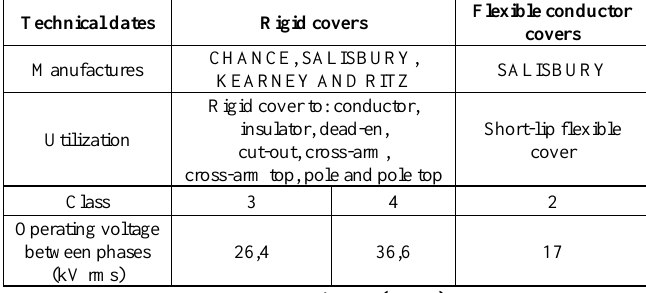
Table 2: Technical data of the insulating covers subjected to individual electrical tests.